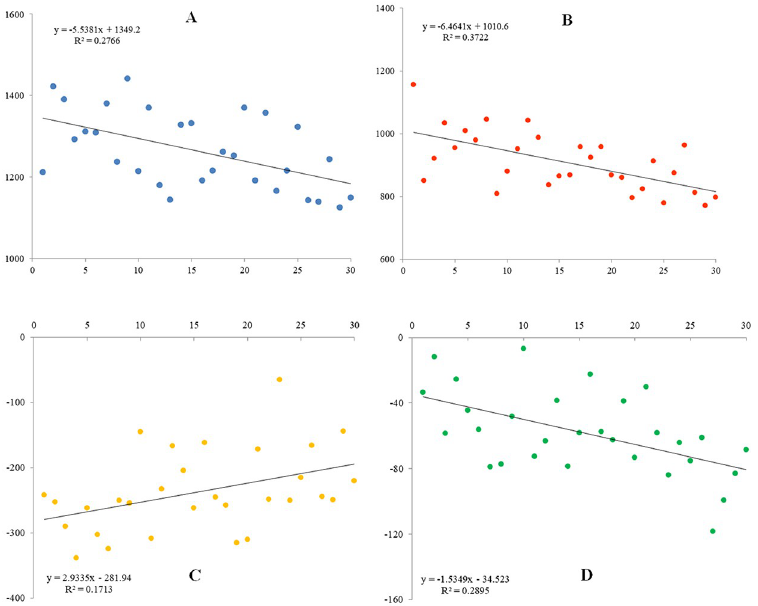
Fig 4. Trend of comprehensive score. A: First principal component score; B: Second principal component score; C: Third principal component score; and D: Fourth principal component score. The X-axis is the ranking, and the Y-axis is each principal